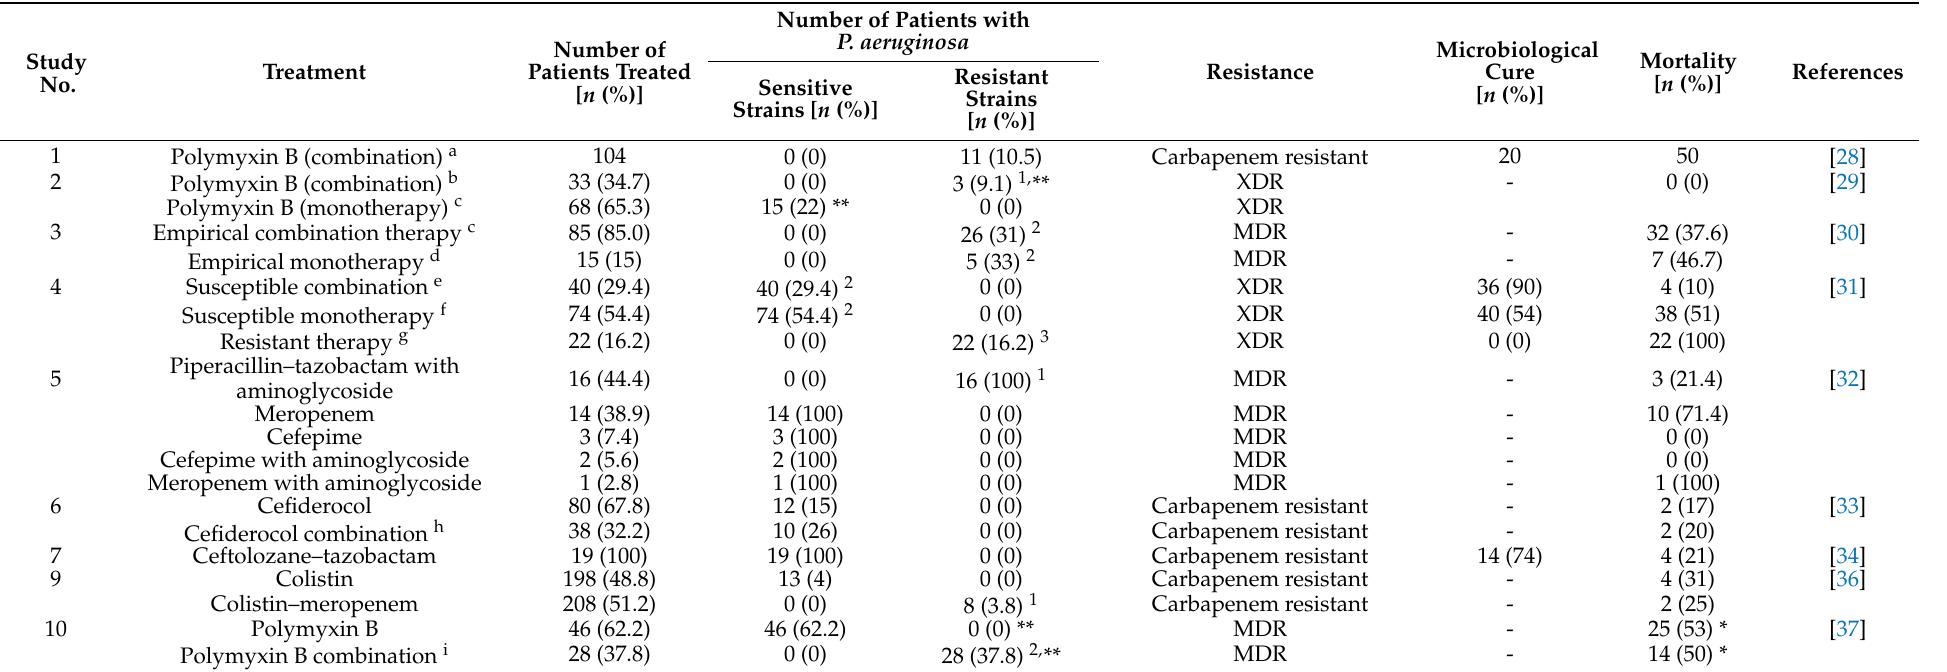
Table 3. Study findings with results separated by